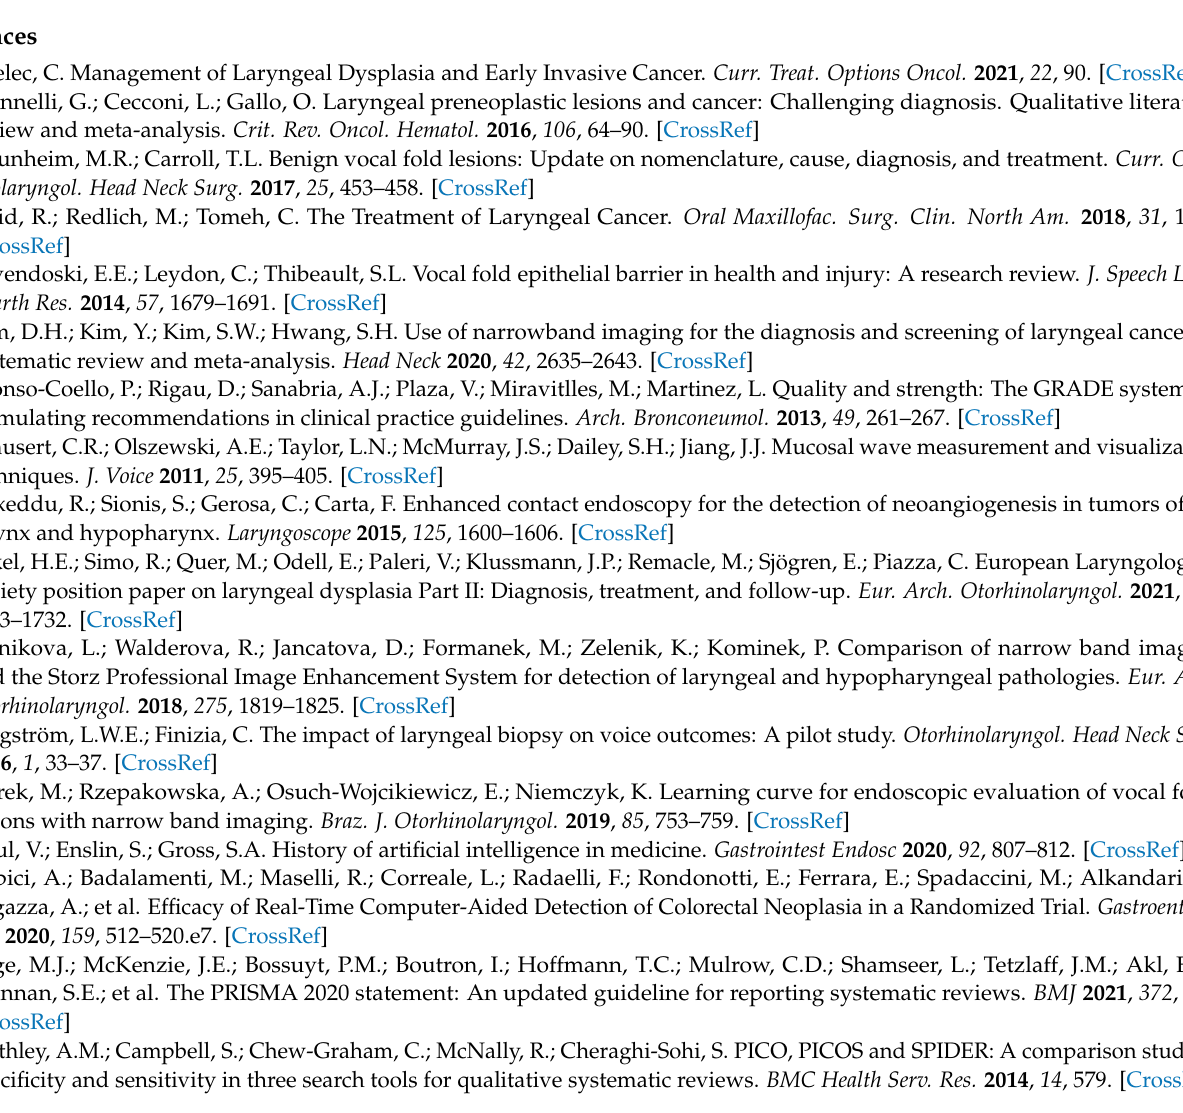
Supplementary Table S2: The tailored QUADAS questions; Supplementary Table S3: Summary table of the studies included in the meta-analysis; Supplementary Table S4: The results of the QUADAS-2 bias and applicability evaluation; Supplementary Table S5: Raw data of the included